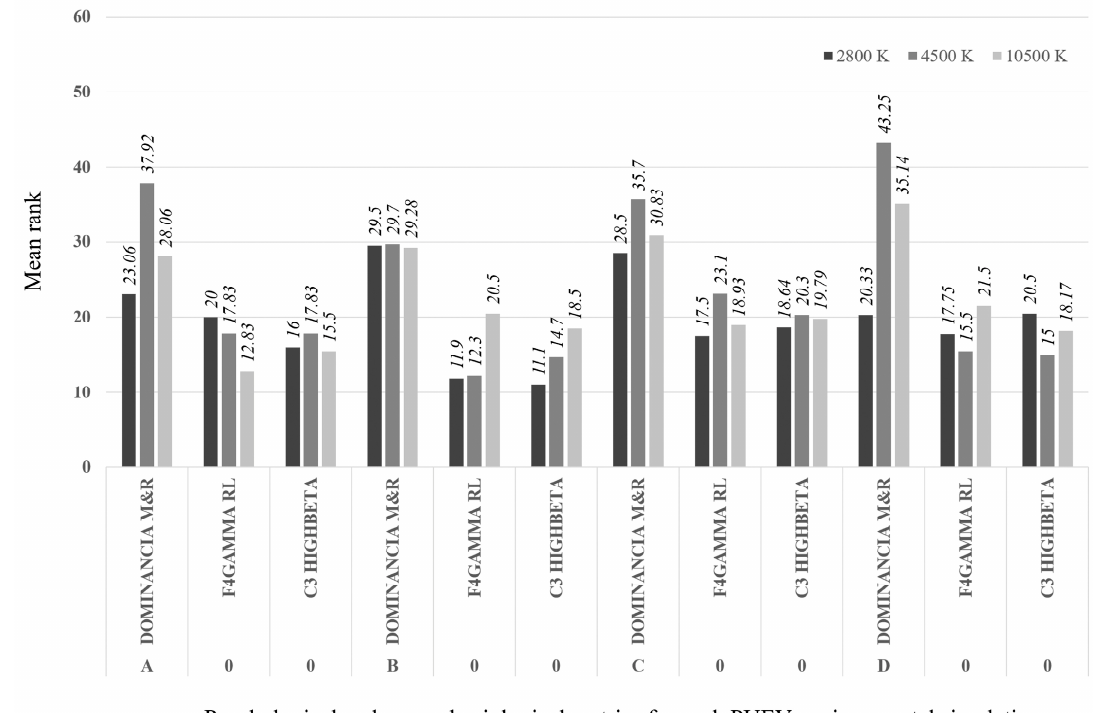
ff ect on the metrics of colour temperature modifications for each Figure 6. Effect on the metrics of colour temperature modifications for each scenario. Figure 6. E